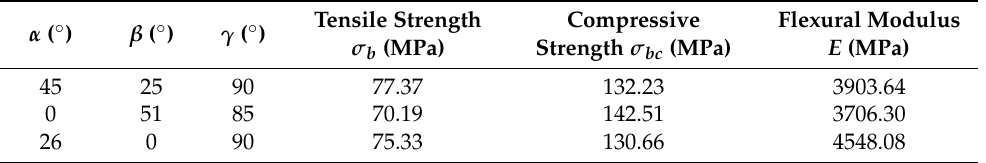
Table 10. The corresponding comprehensive mechanical properties of resin samples in theory with these optimal parameters for the best single mechanical